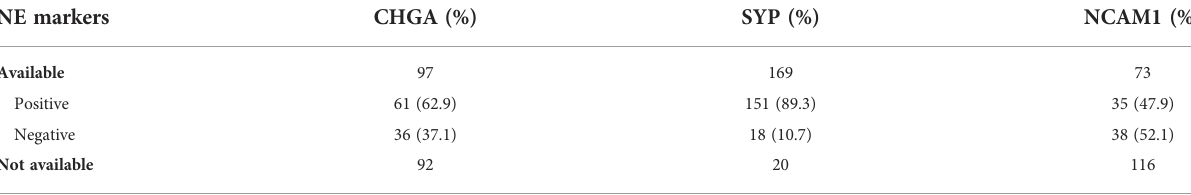
TABLE 1 Summary of NE markers status in 189 prostate cancer cases with neuroendocrine differentiation. NE